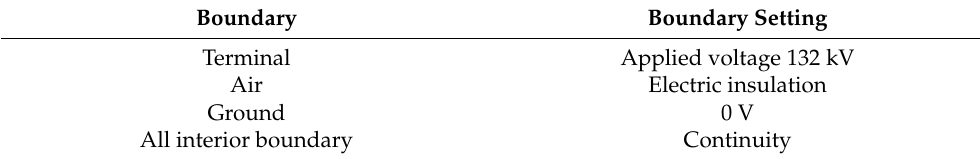
Table 2. Material properties for each part in the model . Table 3. Boundary of the electric